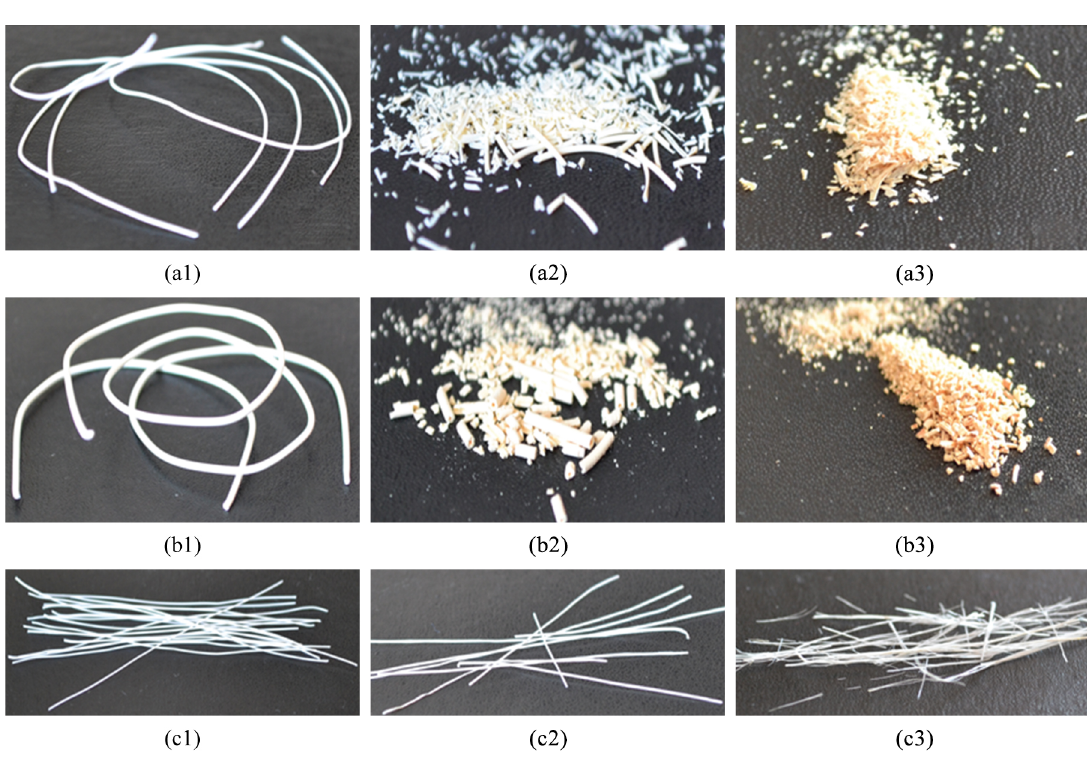
Figure 2. Photographs of polymeric membranes before the contact with ozone: (a1) PES, (b1) PEI and (c1) PP; after 2h of ozone exposition: (a2) PES, (b2) PEI and (c2) PP; and after 4hof ozone exposition: (a3) PES, (b3) PEI and (c3) PP.